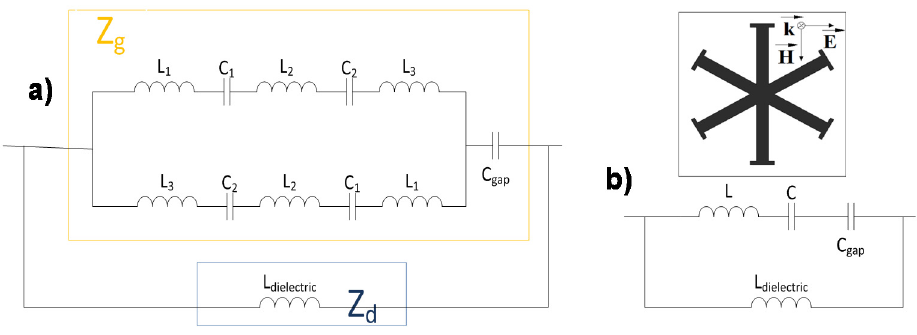
Figure 5. TE polarization: ( a ) Equivalent circuit; ( b ) Simplified